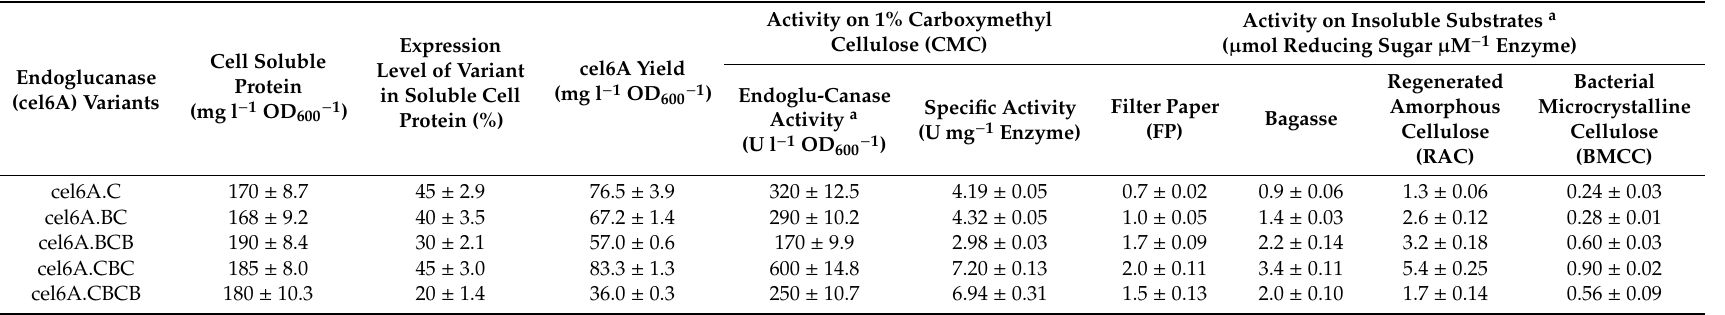
Table 1. Expression levels of cel6A endoglucanase variants in E. coli and their relative activities against soluble and insoluble